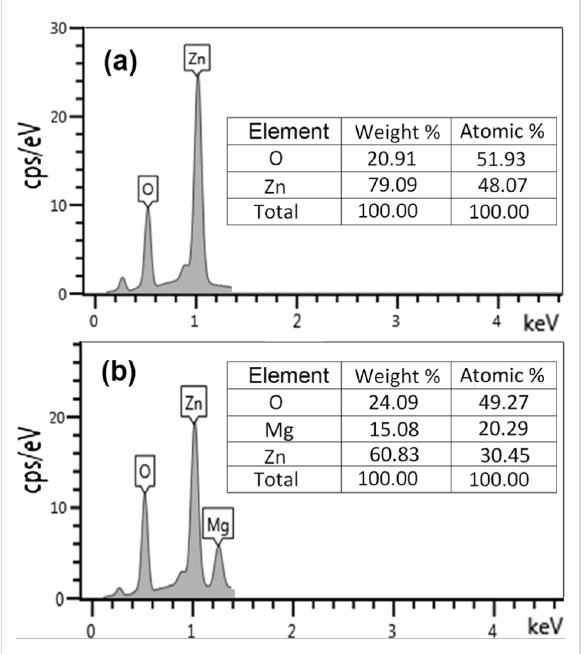
Figure 3: Elemental composition of a ZnO (a) and a Zn 0.6 Mg 0.4 O (b) film determined by EDAX analysis.